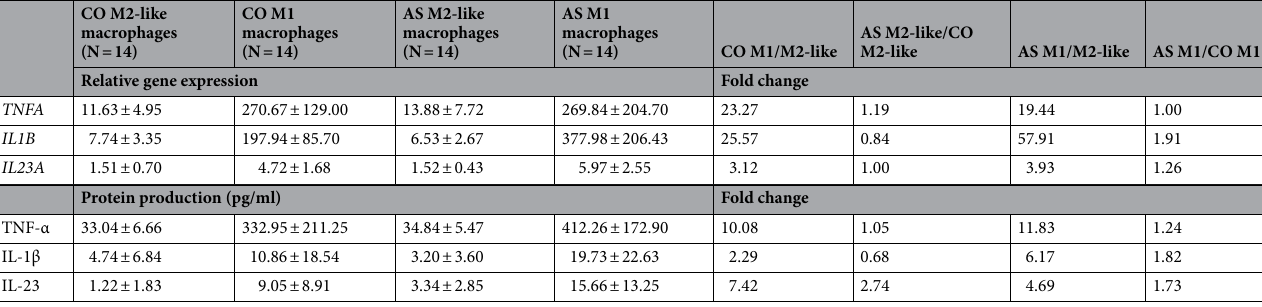
Table 1. The mRNA expression and protein production of IL-23, IL-1β, and TNF-α pro-inflammatory cytokines in monocyte-derived (M2-like) and M1 macrophages from AS patients and healthy controls. Data are presented as mean ± SD. AS ankylosing spondylitis; CO controls; TNF-α tumor necrosis factor-alpha, IL-1β interleukin 1 beta, IL-23